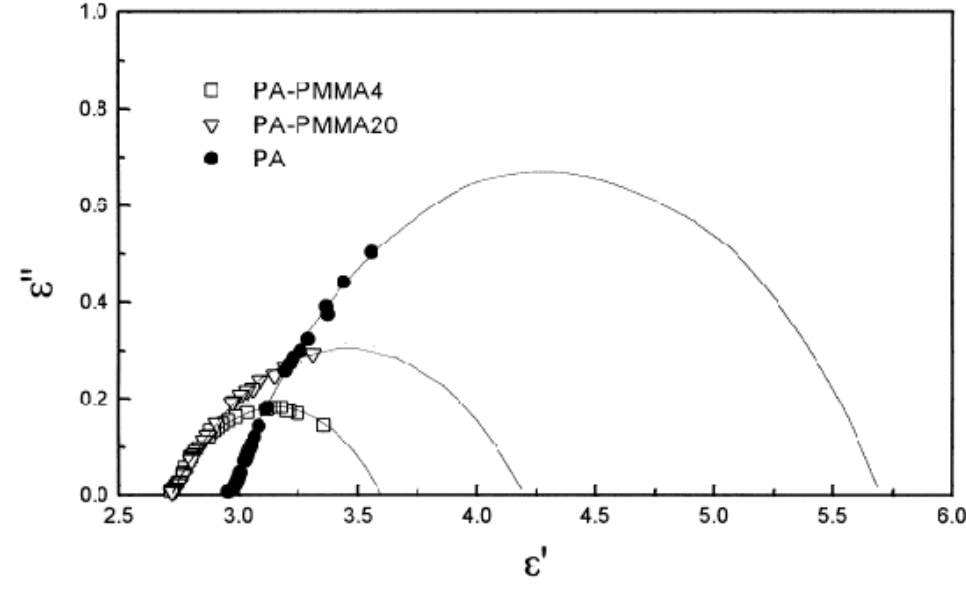
loss factor (red circle) as a function of the frequency; ( b ) Loss factor as a function of the dielectric constant. The solid lines are drawn using Equation (10). (Kim et al. [128], Copyright The Royal Society of Chemistry, 2015).